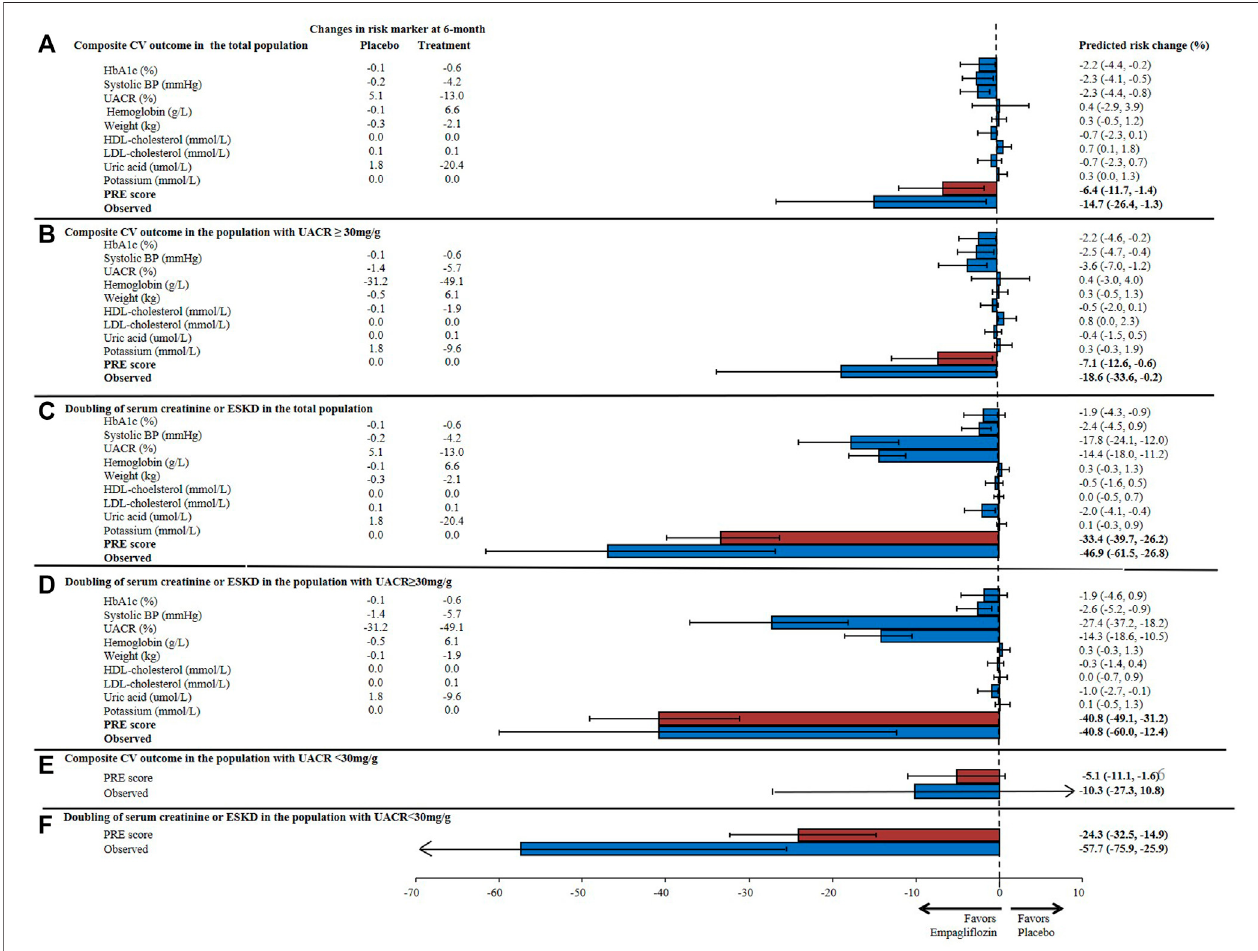
FIGURE 3 | Predicted risk change for (A) the composite cardiovascular (CV) outcome consisting of non-fatal myocardial infarction, non-fatal stroke, or cardiovascular death in the total population; (B) the composite CV outcome in patients with UACR ≥ 30 mg/g; (C) the composite kidney outcome (doubling of serum creatinine or end-stage kidney disease) in the total population; and (D) the composite kidney outcome in patients with UACR ≥ 30 mg/g, (E) the composite CV outcome inpatientswithUACR < 30 mg/g; (F) thecompositekidneyoutcomeinpatientswithUACR < 30 mg/gbaseduponsingleandthemultipleriskmarkerchangesusing the PRE score. Bars indicate the mean percentage reduction in the relative risk with 95% con fi dence intervals, following empagli fl ozin treatment. HbA1c, glycated hemoglobin;BP,bloodpressure;UACR,urinary-albumin-creatinine-ratio;HDL,high-density-lipoprotein;LDL,low-density-lipoprotein;PREscore,ParameterResponse Ef fi cacy